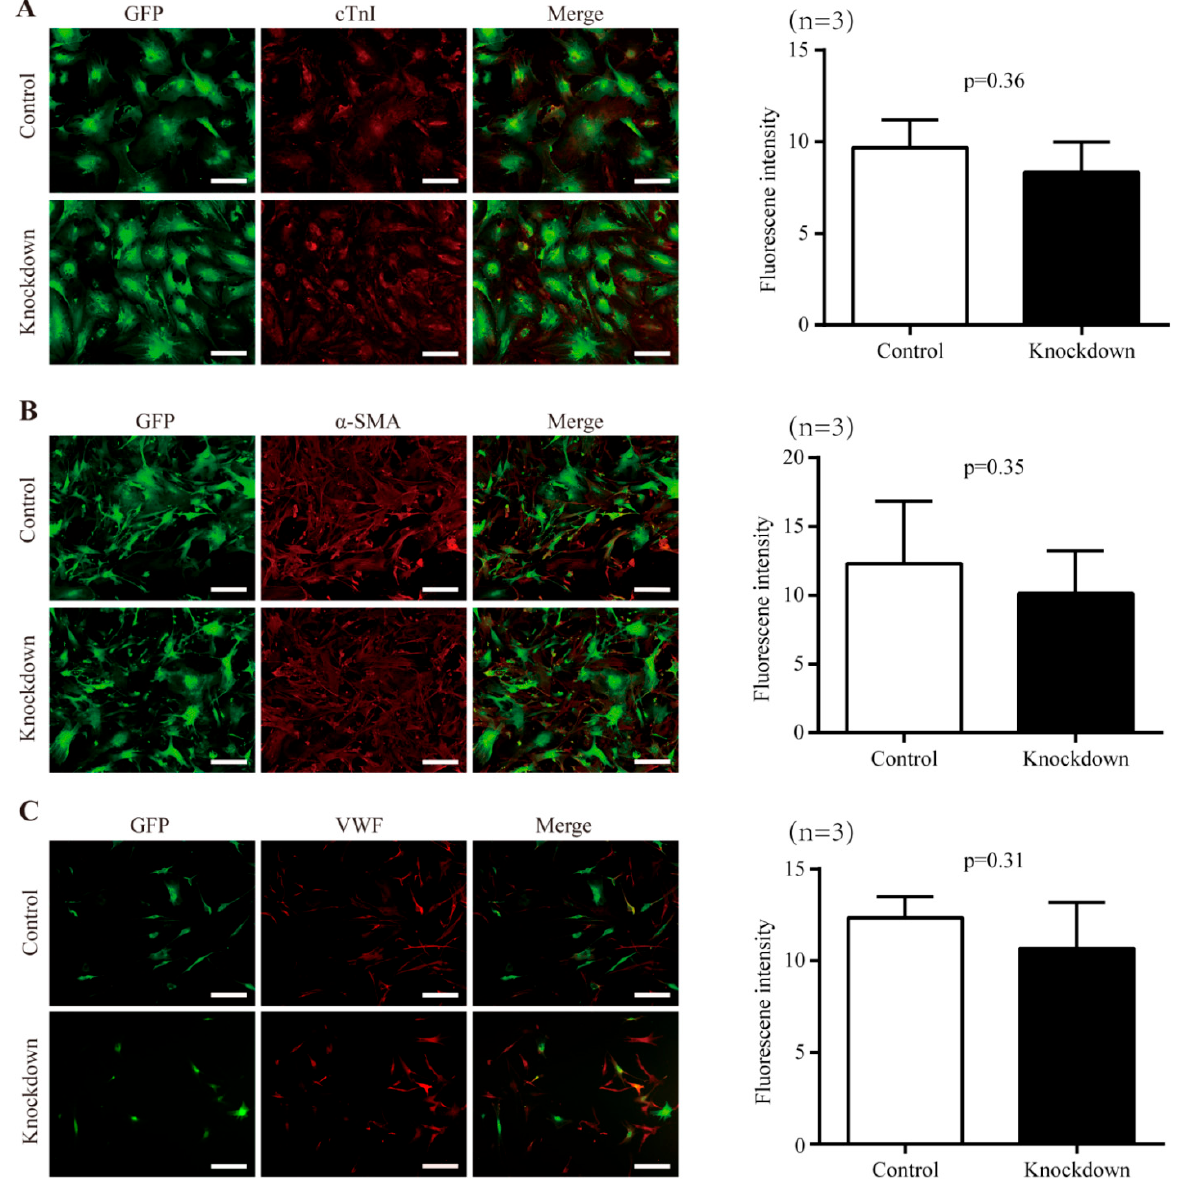
Figure 2. The effect of Nr1d1 knockdown on cell plasticity. ( A – C ) cell differentiation of the old Sca ‐ 1 + CD31 − cell after the Nr1d1 knockdown compared to the negative control group. The left panel shows representative immunofluorescence images stained with cardiomyocyte ‐ specific marker cTnI (red) ( A ), smooth muscle marker α‐ SMA ( B ), and endothelial cell marker VWF ( C ). Sca ‐ 1 + CD31 − cells were marked with GFP merged with DyLight ® 550 (red). Scale bars: 50 μ m. The bar graph on the right panel depicts the grayscale values of DyLight ® 550 within the GFP region as determined by ImageJ and Photoshop, with data from three independent experiments ( n = 3) pre ‐ sented as mean ± SD. Two ‐ tail unpaired t ‐ test was used for the analysis method, and p < 0.05 was considered statistically significant.